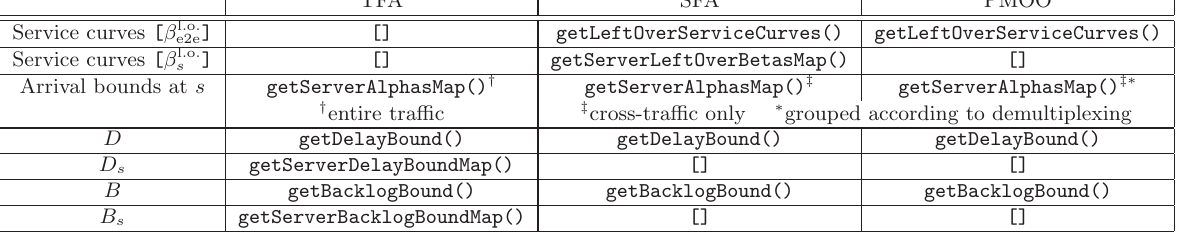
Table 1: Accessing analysis